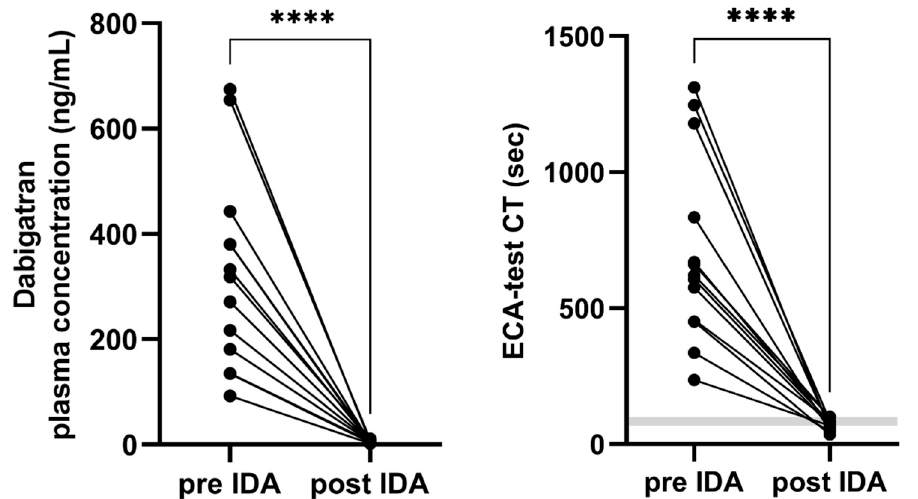
Figure 1. Dabigatran plasma concentration and ClotPro ® ECA-test CT before and after spiking with the specific dabigatran antagonist Idarucizumab. ECA-test: Ecarin based visco-elastic assay; CT: Clotting time; IDA: Idarucizumab; gray area represents normal limits of the specific test. **** p < 0.0001, paired t -test.